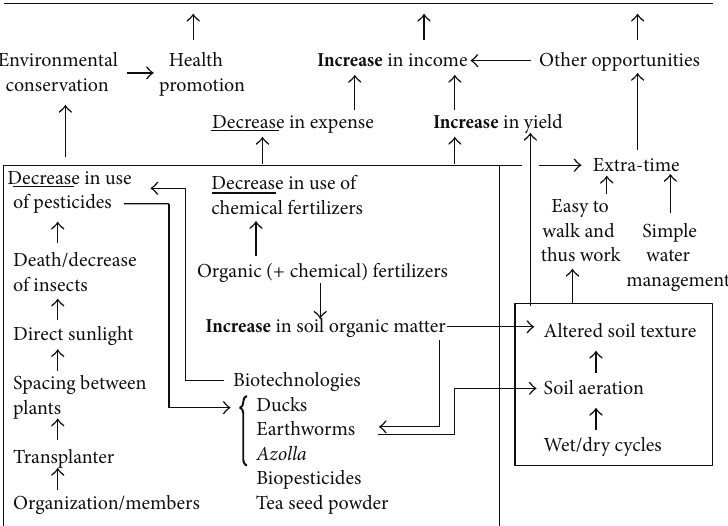
Figure 7: Schematic diagram of components of the Weekend Holiday Farmers’ rice farming system and the